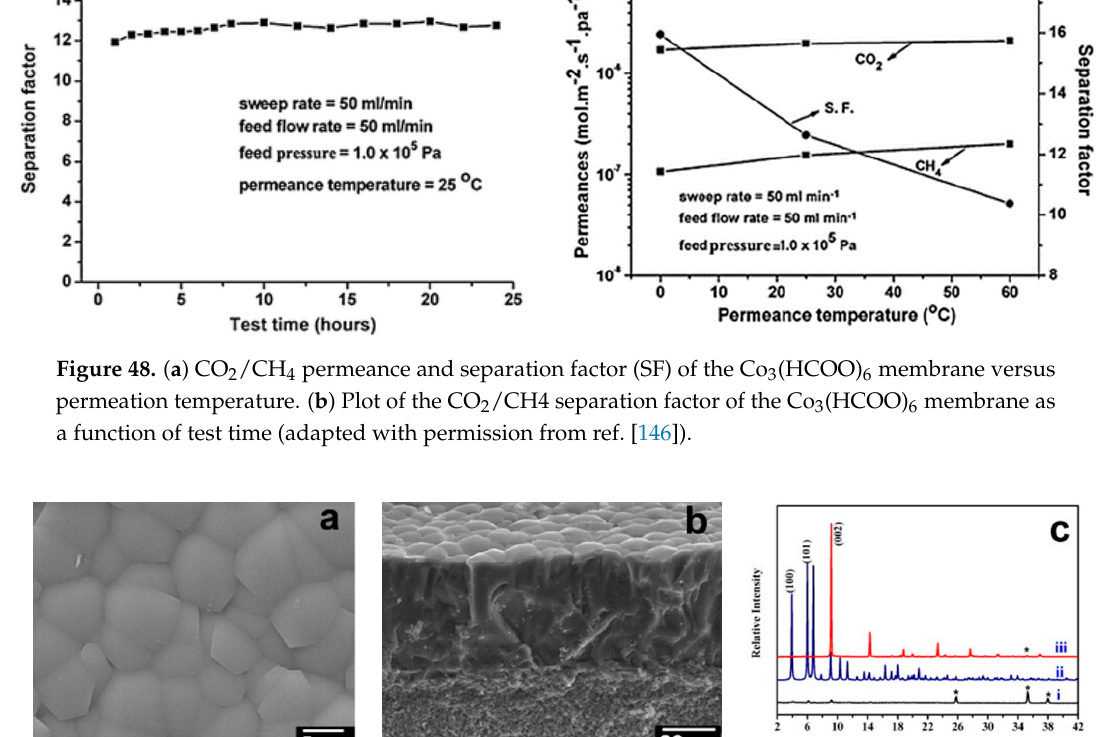
Figure 49. ( a ) Top view of ZIF-69 membrane by secondary growth. ( b ) Cross section view of ZIF-69 membrane by secondary growth. ( c ) XRD patterns for (i) ZIF-69 seeded α -alumina substrate, (ii)